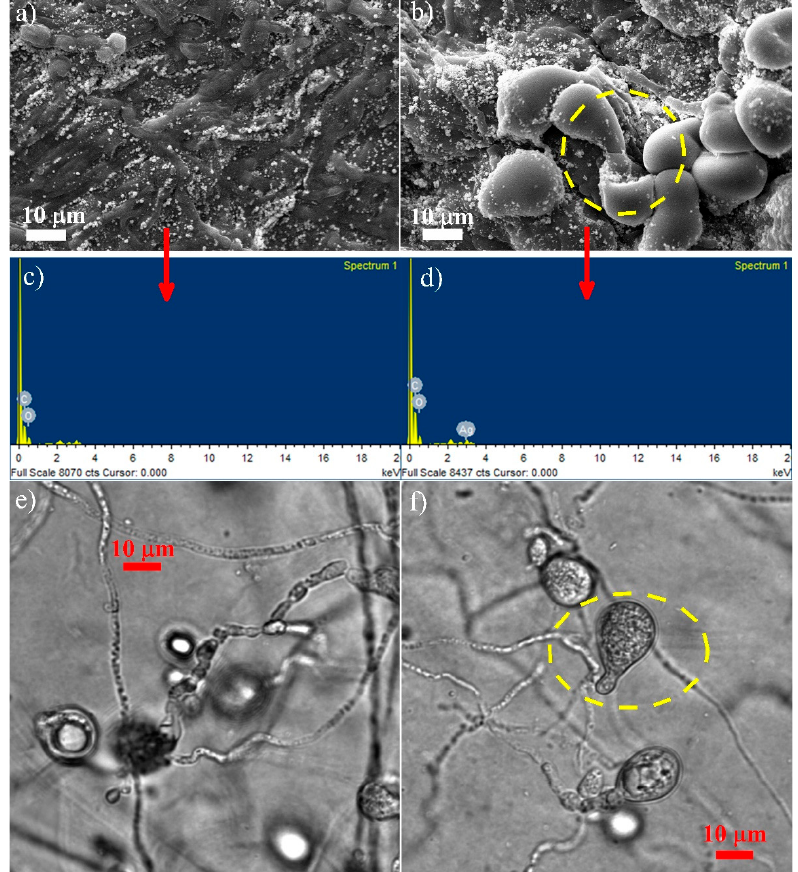
Figure 8. ( a , b ) The Scanning Electron Microscopy of the controlled and treated sample, respectively; ( c , d ) the EDX graphs of the controlled and treated sample, respectively; ( e , f ) the confocal